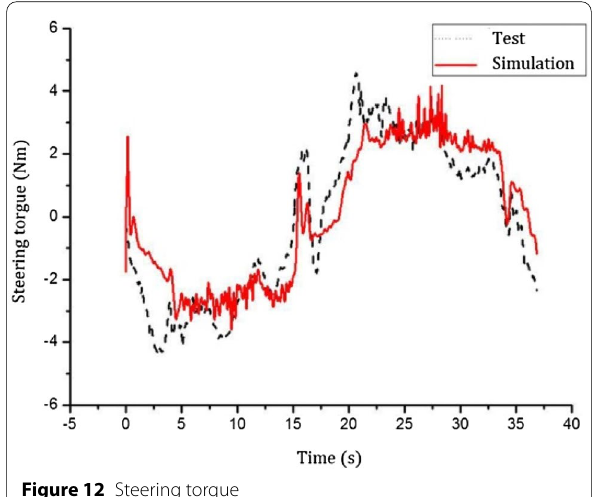
Figure 15 Sensitivity comprehensive analysis of